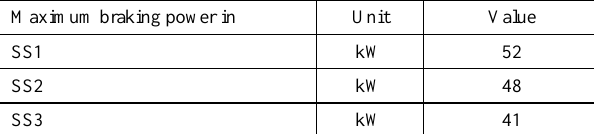
Table 3. Maximum braking power in SS1, SS2 and SS3